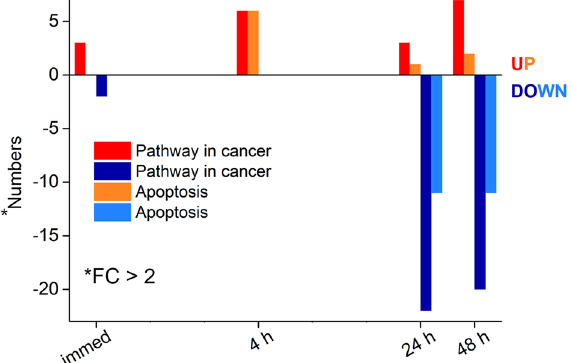
Figure 4. The number of up- and down-regulated genes in cancer and apoptosis pathways, as obtained from KEGG pathway analysis. The red and orange bars represent up-regulation of pathway in cancer and apoptosis, respectively, while the blue and navy-blue bars show down-regulation of pathway in cancer and apoptosis,